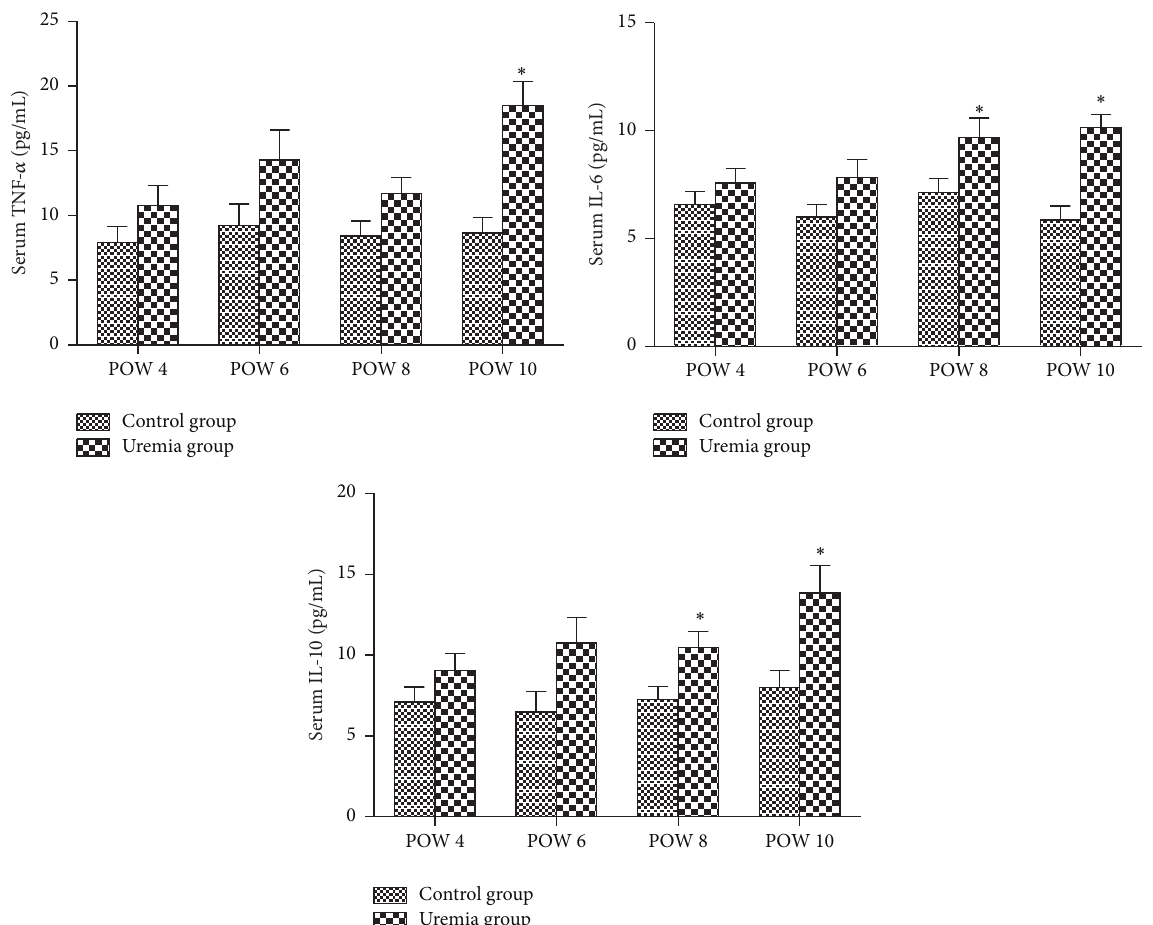
Figure 2: Serum levels of inflammatory cytokines TNF- 𝛼 , IL-6, and IL-10 in each group. POW: postoperative week. Data are expressed as mean ± SD. ∗ 𝑃 < 0.05 , versus control group at the same time point.